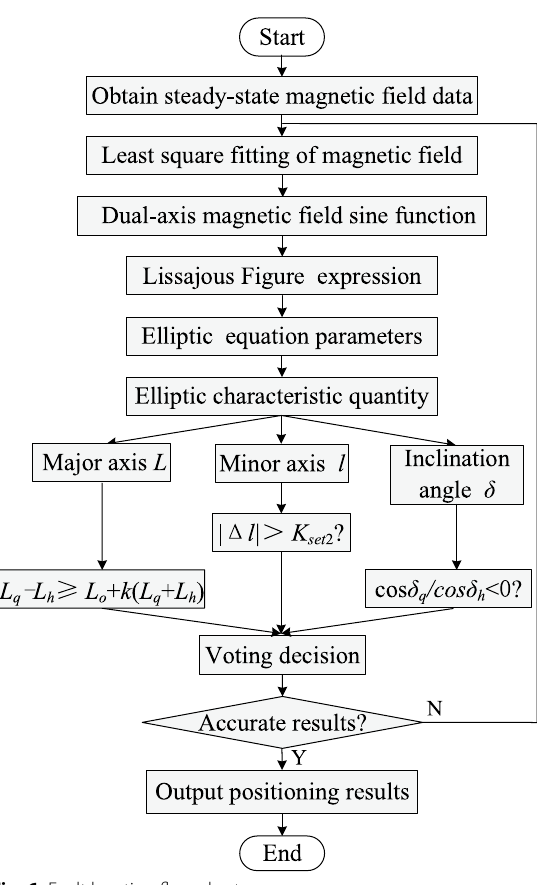
Fig. 6 Fault location flow